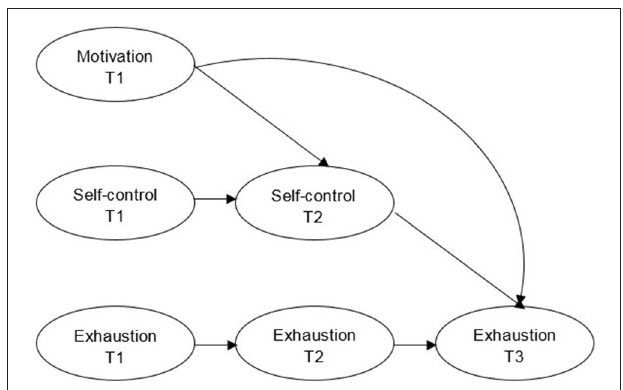
FIGURE 2 | The structural focused longitudinal mediation model. T1, T2, and T3 = time point one, two, and three.